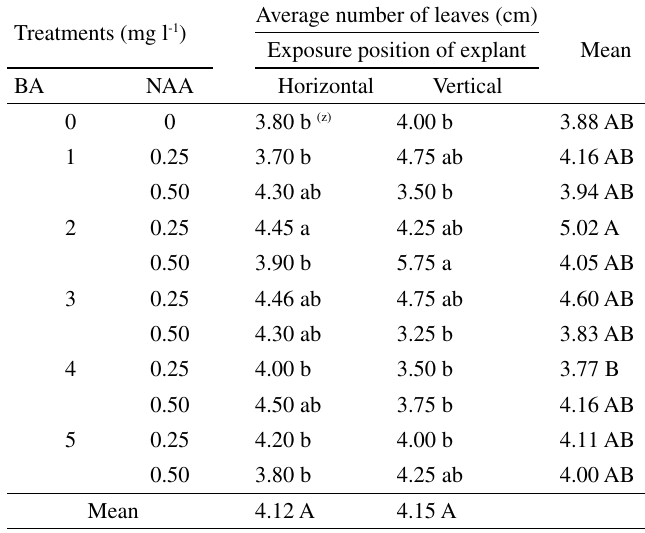
Table 5 - The interaction effect of different concentrations of BA and NAA, and exposure position of explants on the average leaf number in ‘Green’ Average number of leaves (cm) Treatments (mg l -1 )